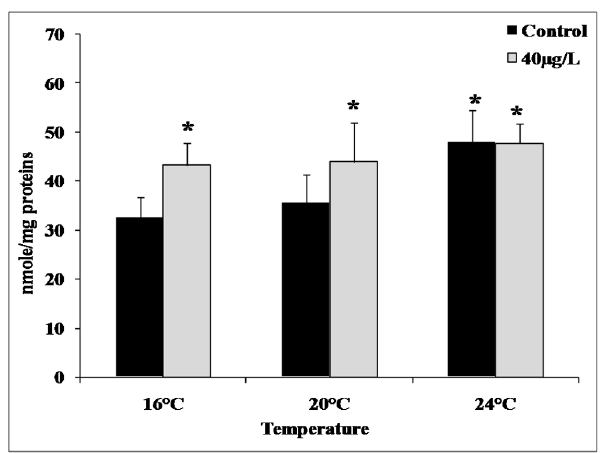
Figure 3. Malondialdehyde (MDA) accumulation in Mytilus galloprovincialis gills (Panel B) in animals exposed for 4 days to 40 m g/L Cu along with a temperature gradient (16 6 C and 24 6 C). Data, expressed in nmole/mg proteins (n=10), were analyzed by ANOVA + Tukey’s post test. *: Statistically significant differences (P , 0.01) in comparison with control condition (16 u C without Cu supply).